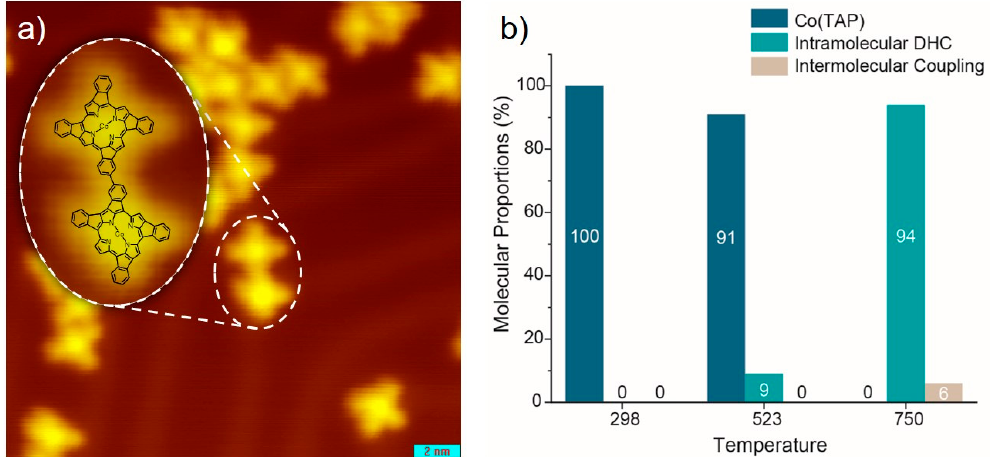
Figure 4. ( a ) An STM image of the annealed Co(TAP) self-assembly on the surface at 750 K. The intermolecular coupling product is marked by the white dashed oval and superimposed with its chemical structure on an enlarged image. ( b ) Statistic histograms of Co(TAP), intramolecular DHC and intermolecular coupling products at different reaction temperatures. Imaging conditions: − 0.3 V, 50 pA. Image size: 20 × 20 nm 2 .